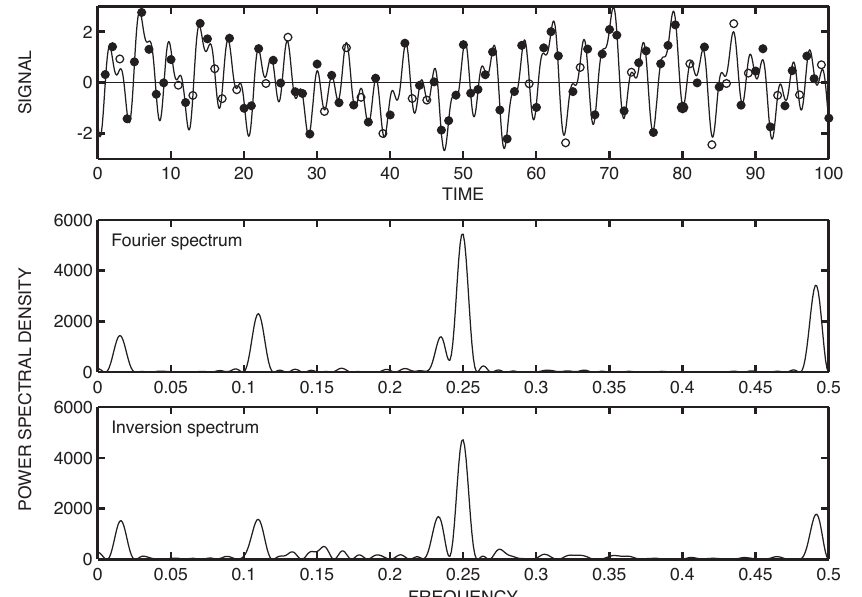
Fig. 4. Same as Fig. 2 but random Gaussian noise with a satandard deviation of 0.3 has been has been added to the samples. The number of dropped samples is 26.